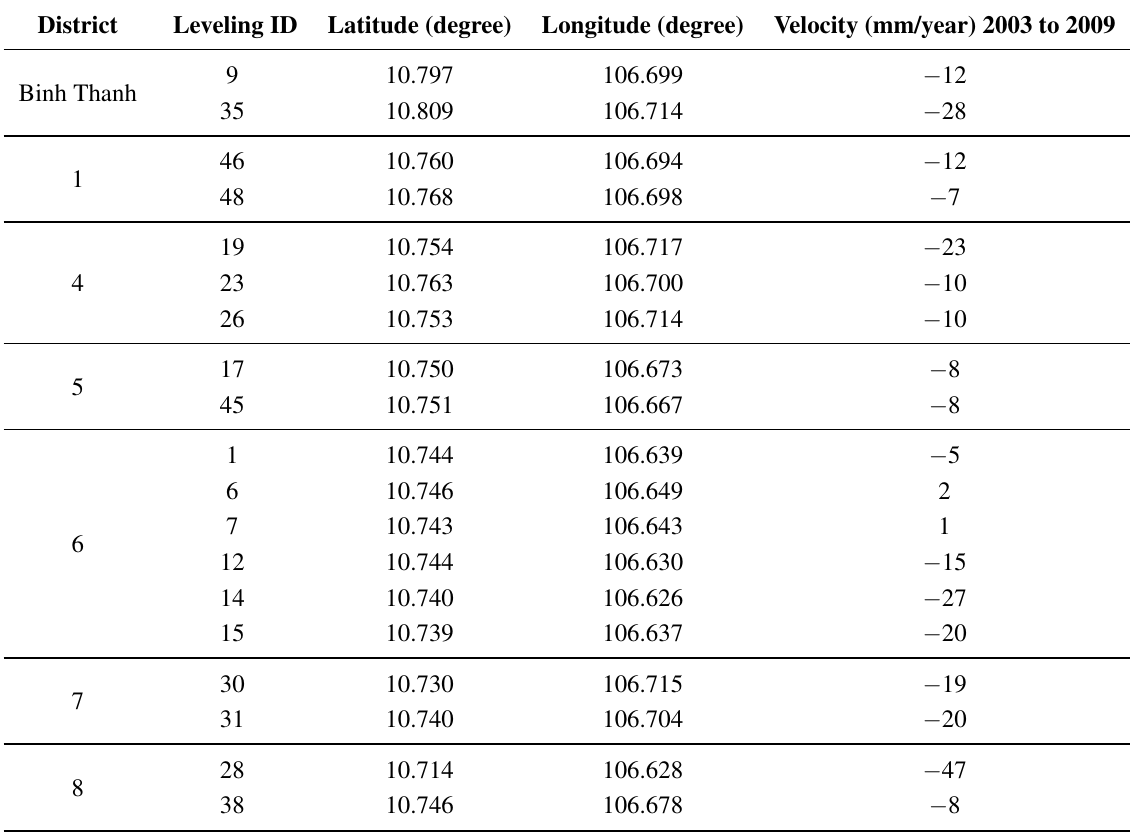
Table A1. Locations of in situ leveling measurement sites.